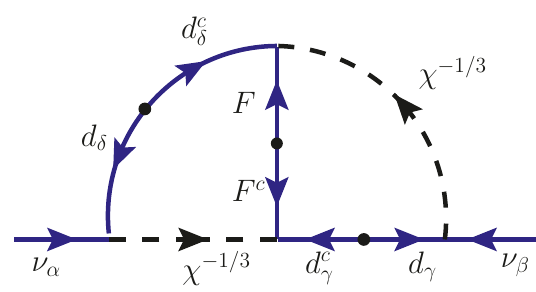
Figure 47 . Two-loop neutrino mass generation in the Angelic model [35]. This model induces operator of ref. O 11